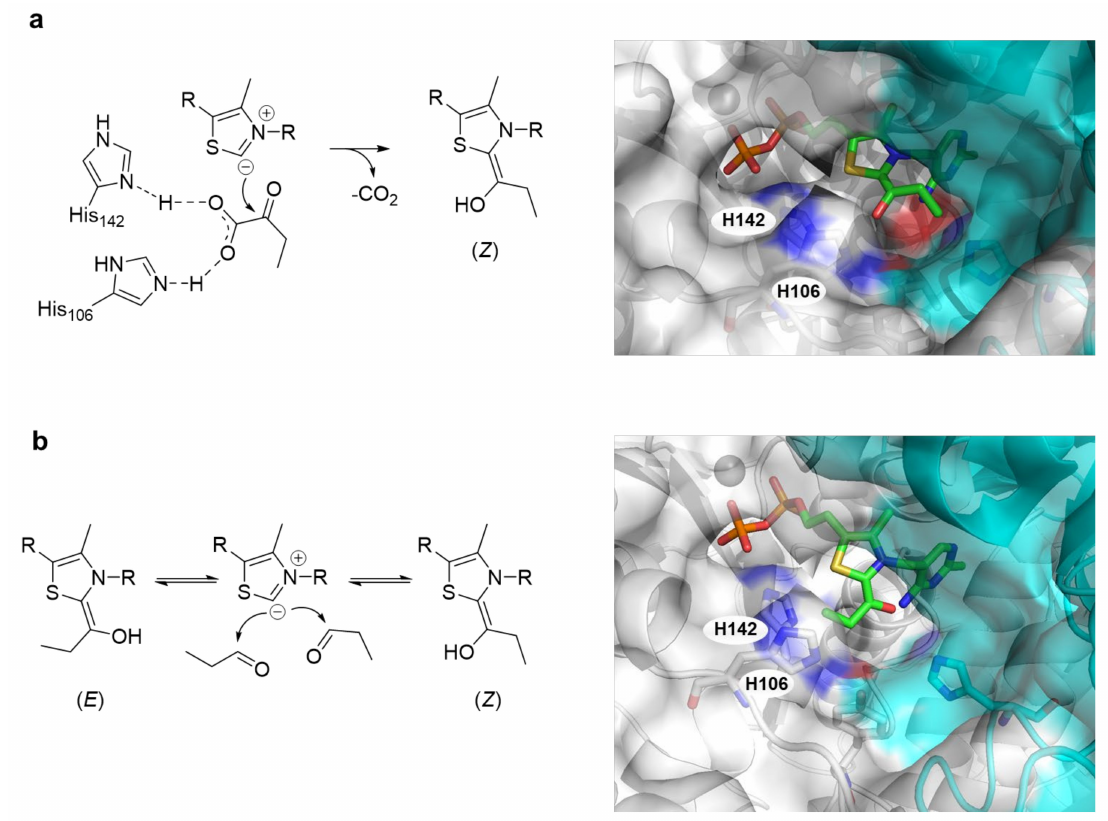
Figure 5. ( a ) The presence of two histidine residues (H106 and H142, surface polarity shown in blue) presumably guides the approach of negatively charged ketoacid substrates into the active